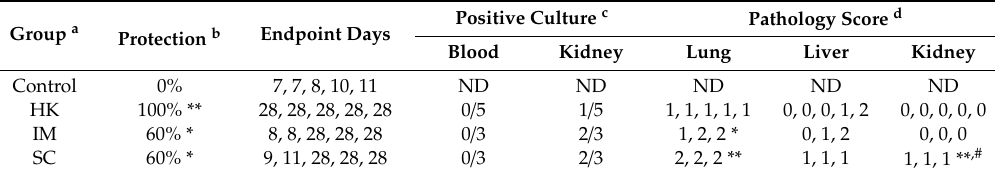
Figure 3. Kaplan–Meier plot of survival rates in vaccinated hamsters (n = 5 per group) following lethal challenge by virulent Leptospira . The hamsters were immunized with various vaccine formulations shown in Table 1. Each vaccinated hamster was challenged by 20 × LD50 of low passage leptospires. The percent survival was calculated as the number of survivors / total challenged hamsters × 100. Statistical analysis of survival rates between control group and other vaccinated groups was performed by log-rank test. Table 2. Protective efficacy conferred by different vaccine formulations.